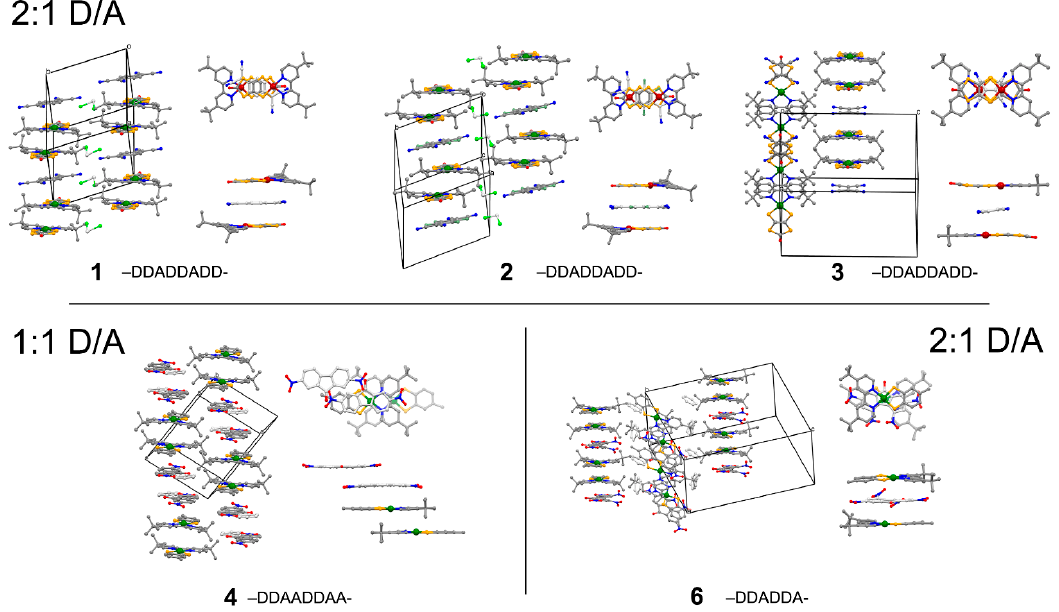
Figure 2. Top: Crystal packing of [Pt(dbbpy)(dmid)] 2 [TCNQ]·2CH 2 Cl 2 ( 1 ) [Pt(dbbpy)(dmid)] 2 [TCNQF 4 ]·2CH 2 Cl 2 ( 2 ) and [Pt(dbbpy)(dmid)] 2 [TCNE]·C 6 H 6 ( 3 ) [17]. All systems exhibit a columnar stack with a 2:1 D/A -DDADDADD- pattern. Two columnar stacks are depicted in the packing. Bottom, left: crystal packing of [Pt(dbbpy)(tdt)][DNF]·0.5C 6 H 6 ( 4 ) having a columnar stack with a 2:2 D/A -DDAADDAADD- pattern. Two columnar stacks are depicted in the packing. Bottom, right: crystal packing of [Pt(dbbpy)(tdt)] 2 [TENF]·2C 6 H 6 ( 6 ) having a columnar stack with a -DDADDADDA- pattern [11]. Three columnar stacks are depicted in the packing.